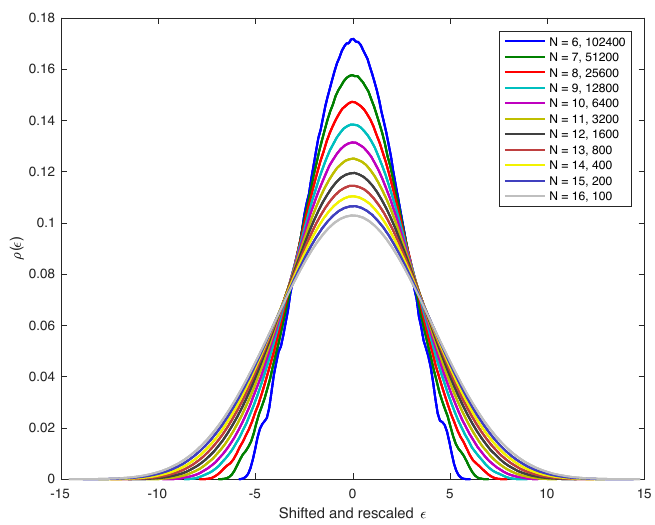
Figure 9 . Spectrum of the local spin chain (Local-RCQ) for N = 6 to 16, as well as number of samples used for each N: Spectrum appears close to Gaussian as low as N = 6, where it starts developing edges characteristic to semi-circle